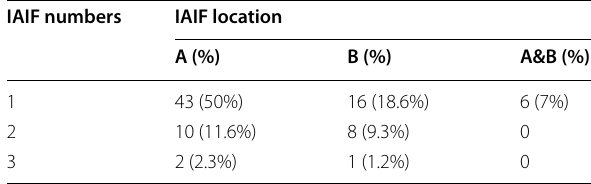
Table 4 Univariate analysis results for the relation of IAIF